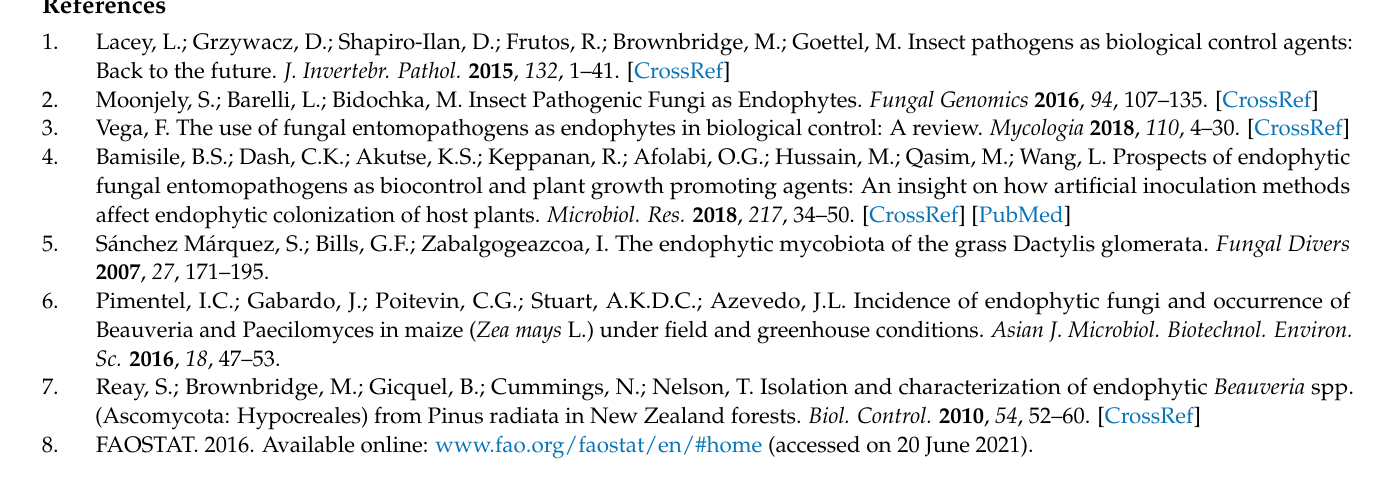
Figure S2. Average long-term temperatures and precipitation at the surveyed locations. Figure S3. Content of carbon (Cmic) and nitrogen (Nmic) in the microbial biomass from the investigated soils as analyzed by the fumigation–extraction method. Figure S4. Rarefaction analysis of the investigated samples. Table S1. Granulometric composition of soil samples from experimental plots, as determined by laser diffraction using a Fritsch Analysette-22 MicroTec device. Table S2. Agrochemical properties of soils from the experimental plot locations. File S1. MiSeq data at the OTU, genus, order, class, and phylum